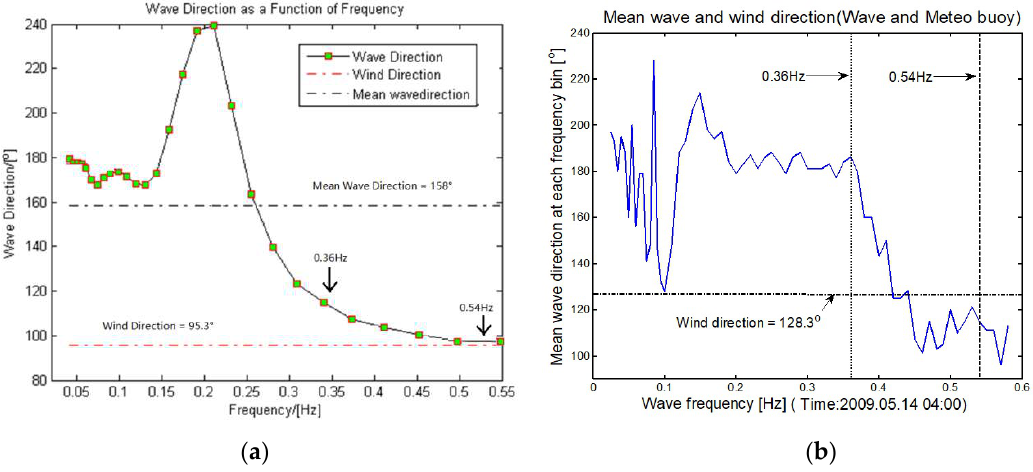
Figure 5. Wind direction and wave direction at each frequency bin. ( a ) WAM (wave model) data; ( b ) in situ measurement at the Thyrrenian Sea, Italy.